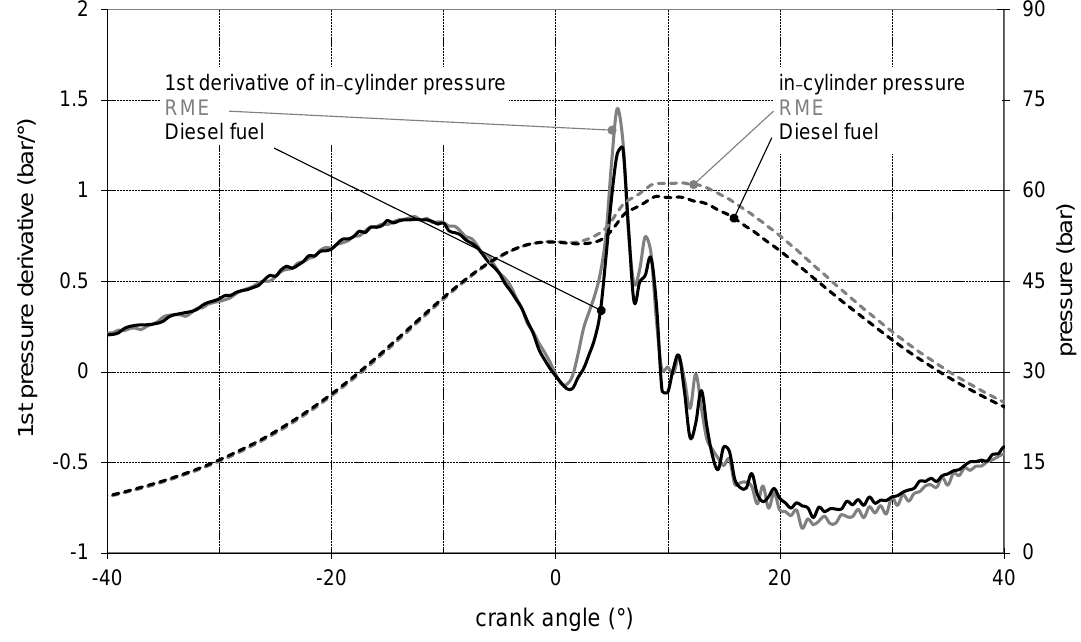
Figure 16. RME and diesel fuel in-cylinder pressures and rate of pressure rise at 2250 rpm and at full load.